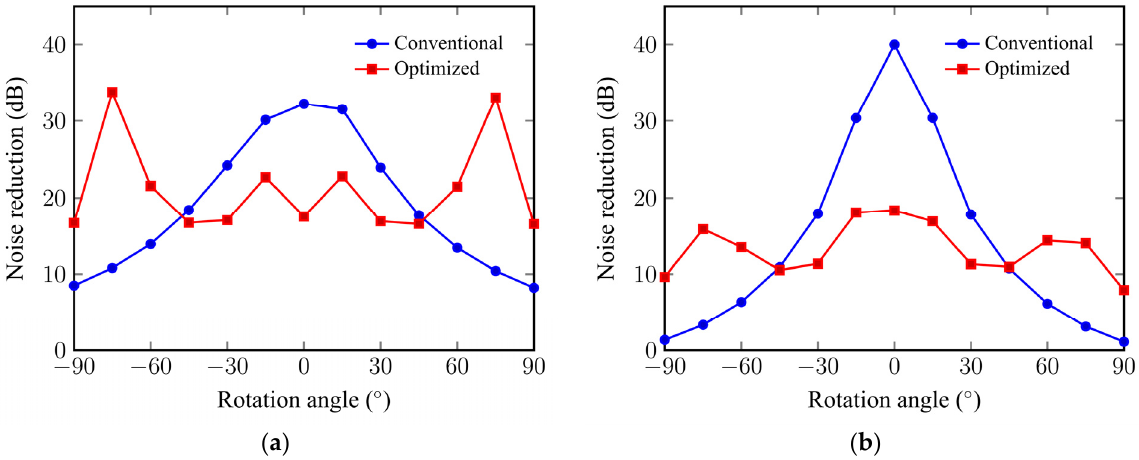
Figure 10. Noise attenuation at different frequencies when head rotates: ( a )125 Hz, ( b )500 Hz.